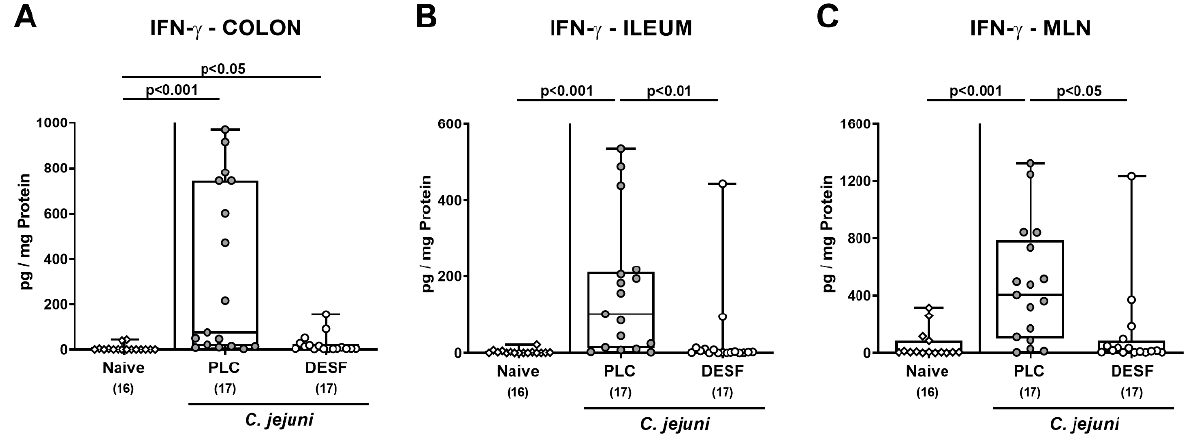
Figure 5. Pro-inflammatory IFN- γ responses in distinct parts of the intestinal tract following C. jejuni infection of microbiota-depleted IL-10 − / − mice that had been pretreated with deferoxamine. Microbiota-depleted IL-10 − / − mice were subjected to desferoxamine (DESF, white circles) pretreatment via the drinking water starting 7 days prior infection or received autoclaved tap water only (PLC; grey circles). On days 0 and 1, mice were perorally infected with C. jejuni strain 81-176. On day 6 post-infection, IFN- γ concentrations were measured in supernatants taken from overnight cultures of intestinal ex vivo biopsies such as the ( A ) colon, ( B ) ileum, and ( C ) mesenteric lymph nodes (MLN). Uninfected and untreated mice served as negative controls (white rhombus). Whiskers indicating the total range, boxes indicating the 25th and 75th percentiles of the medians (black bars inside boxes), significance levels ( p values) calculated by the Kruskal–Wallis test with Dunn’s post-correction, and the total numbers of analyzed mice (in parentheses) are given. Shown data were pooled from three independent experimental sets.